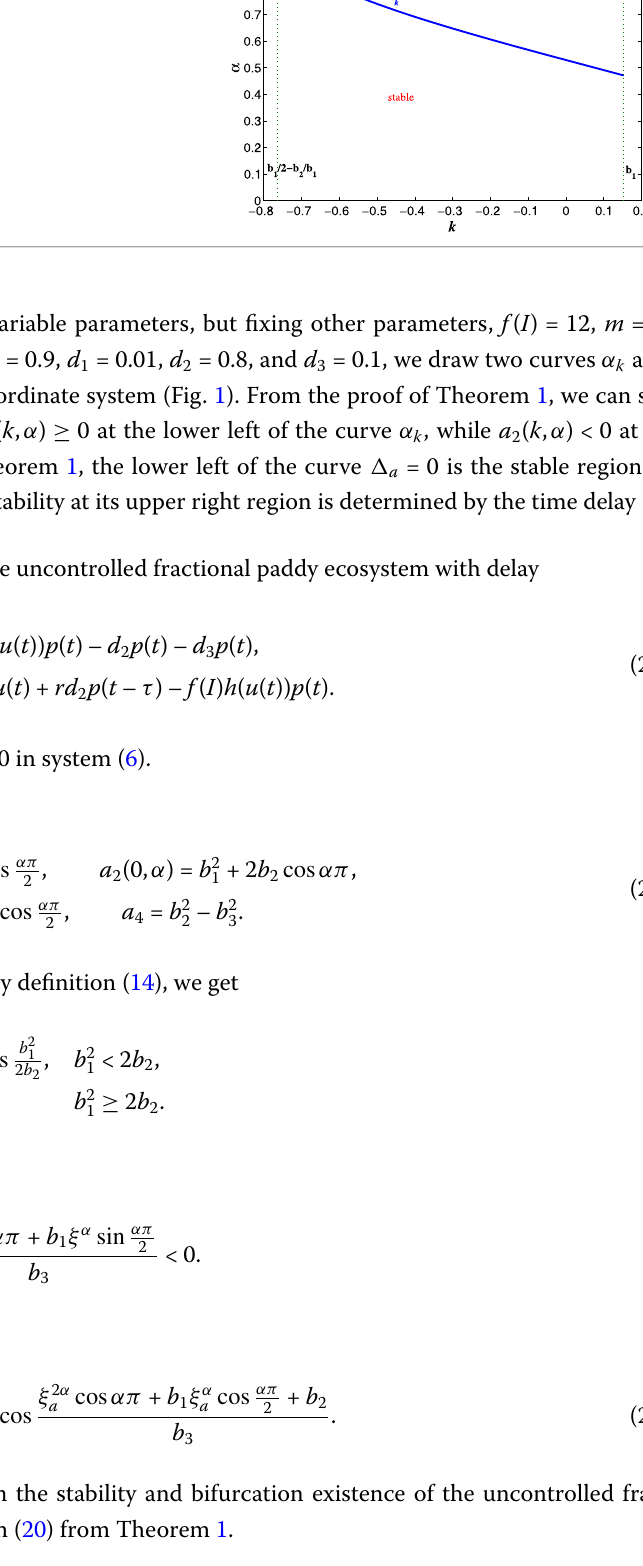
Figure 1 The stable region of system (6). The curve α k is defined by (14). The (cid:5) a defined in (5) is the discriminant of polynomial